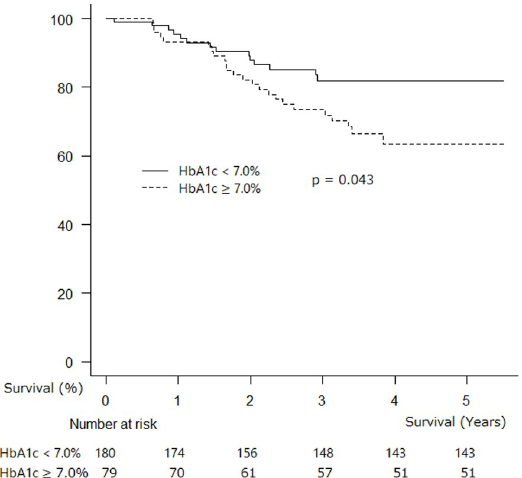
Fig 2. Kaplan–Meier survival probability curve for postsurgical patients with HbA1c < 7.0% and HbA1c � 7.0% (adjusted for age and gender).